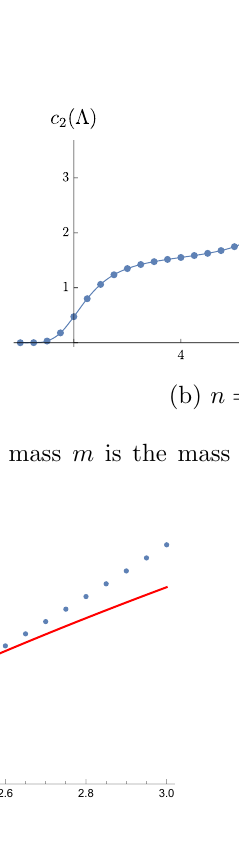
Figure 7. The value of c ((cid:3)) in the middle of the plateau (blue dots) compared with the real part of c at the complex (cid:12)xed points (red line). The discrepancy is small for n close to 2, where the complex CFTs are close to the real axis. As n increases, the complex (cid:12)xed points move further away from the real axis and the c-function of the walking theory starts to di(cid:11)er from the real part of the central charge of the complex CFTs. At this point one needs to include corrections from conformal perturbation